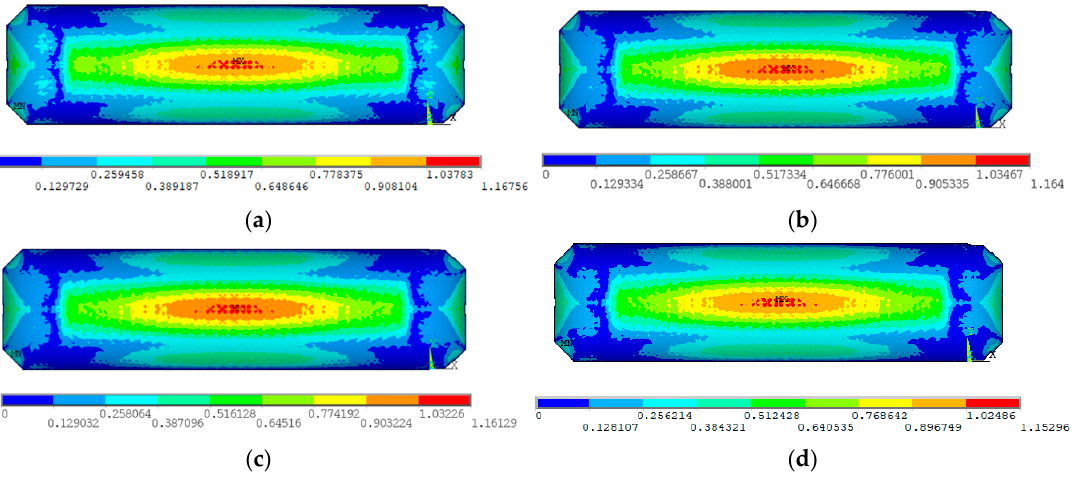
Figure 4. Cloud chart of membrane surface displacement (unit: m): ( a ) μ = 0.2; ( b ) μ = 0.44; ( c ) μ = 0.68; and ( d ) μ = ∞ *.